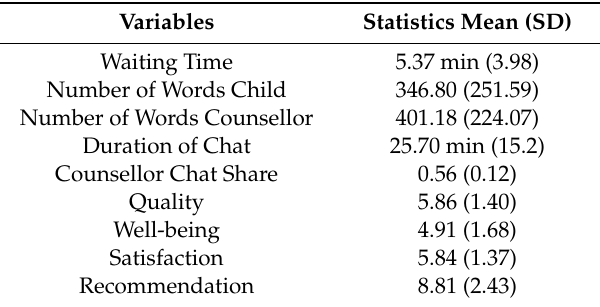
Table 2. Summary statistics of sample ( n = 673).